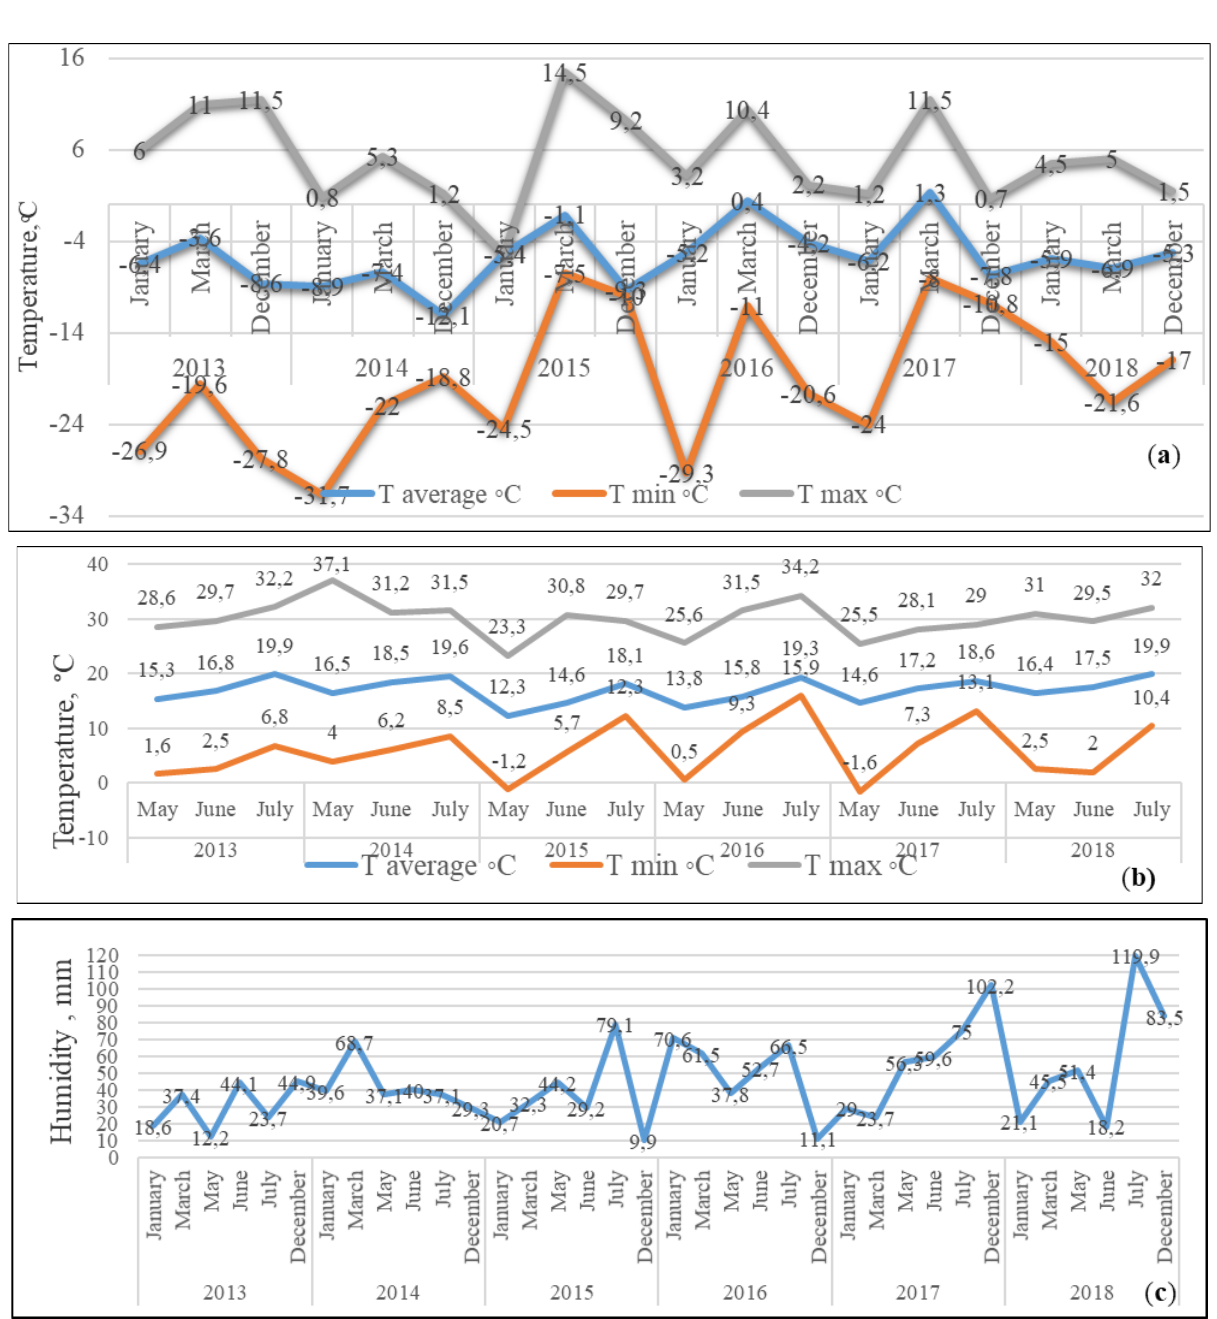
Figure 10. ( a ) Monthly average, minimum, and maximum air temperatures during: ( b ) dormancy and ( c ) growing period, and the amount of precipitation during dormant and growing seasons at the Zhilina, Orel District, Orel Region, and Russian Federation. The soil of the site was loamy haplic luvisol. The thickness of the humus horizon is 30–55 cm. Some important agrochemical indicators of experimental soil, determined by standard methods [74], are presented in Table